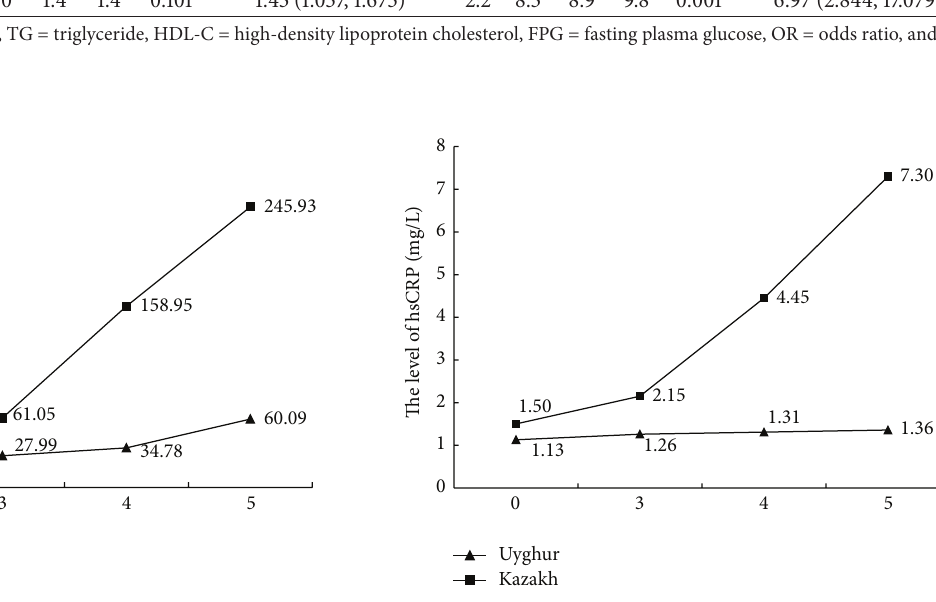
Figure 1: Comparing IL-6 with MS components. Figure 2: Comparing hsCRP with MS